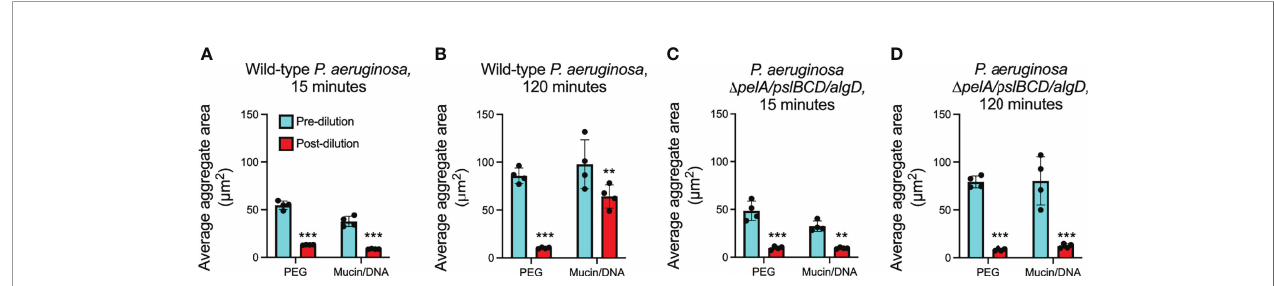
FIGURE 3 | Depletion aggregate dispersal phenotypes of P. aeruginosa in PEG or mixtures of mucin/DNA. (A, B) Fluorescent P. aeruginosa PAO1 (wild type) or (C, D) the exopolysaccharide triple mutant D pelA/pslBCD/algD were aggregated by either PEG 35 kDa or a mixture of mucin and DNA. Fifteen- or 120-minutes post-aggregation, cultures were diluted 10X with PBS; fl uorescent images were acquired immediately pre- and immediately post-dilution. The area of fl uorescent aggregates was measured using Velocity image analysis software. The mean ± SD of at least 100 aggregates per replicate (n = 4) is shown, **P<0.01, ***P<0.001, Student ’ s t -test. See representative aggregate images in Figure S3 .